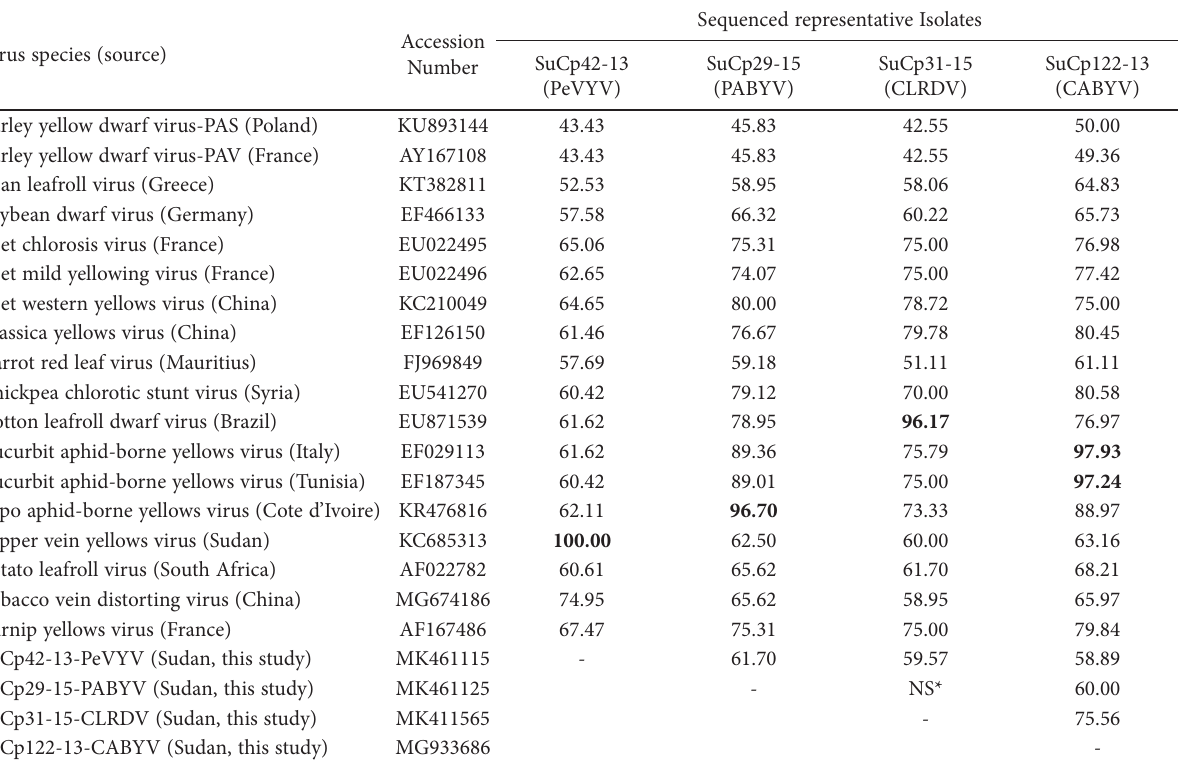
Table 5. Pairwise comparisons of the percentage amino acid sequence similarities for partial CP gene (AS3/Pol3870F fragment) of four distinct luteovirid sequences amplified from four representative samples with that of other luteovirids from the database and to each